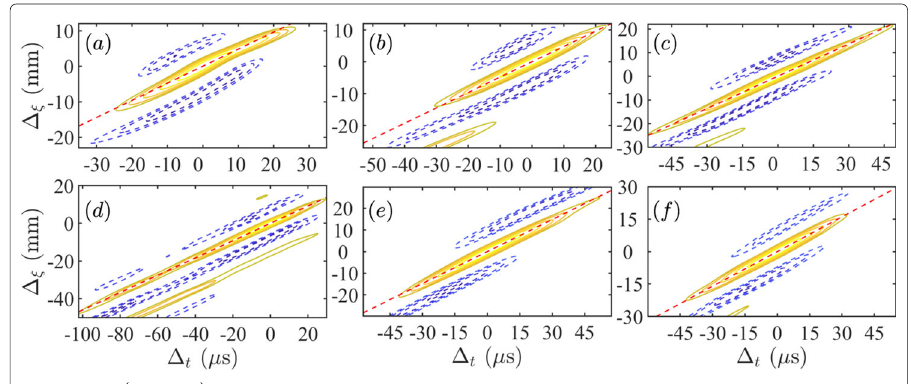
(cid:2) (cid:3) (cid:7) ξ ,0, (cid:7) for low-frequency wall pressure at probe points in Group 2. Contour levels are Fig. 16 C pp t [0.5:0.1:1] for solid and [-1:0.1:-0.5] for dashed. The slopes of the dashed lines are 0.45 q ∞ in a , 0.5 q ∞ in b , 0.425 q ∞ in c , 0.43 q ∞ in d , 0.46 q ∞ in e and 0.45 q ∞ in f